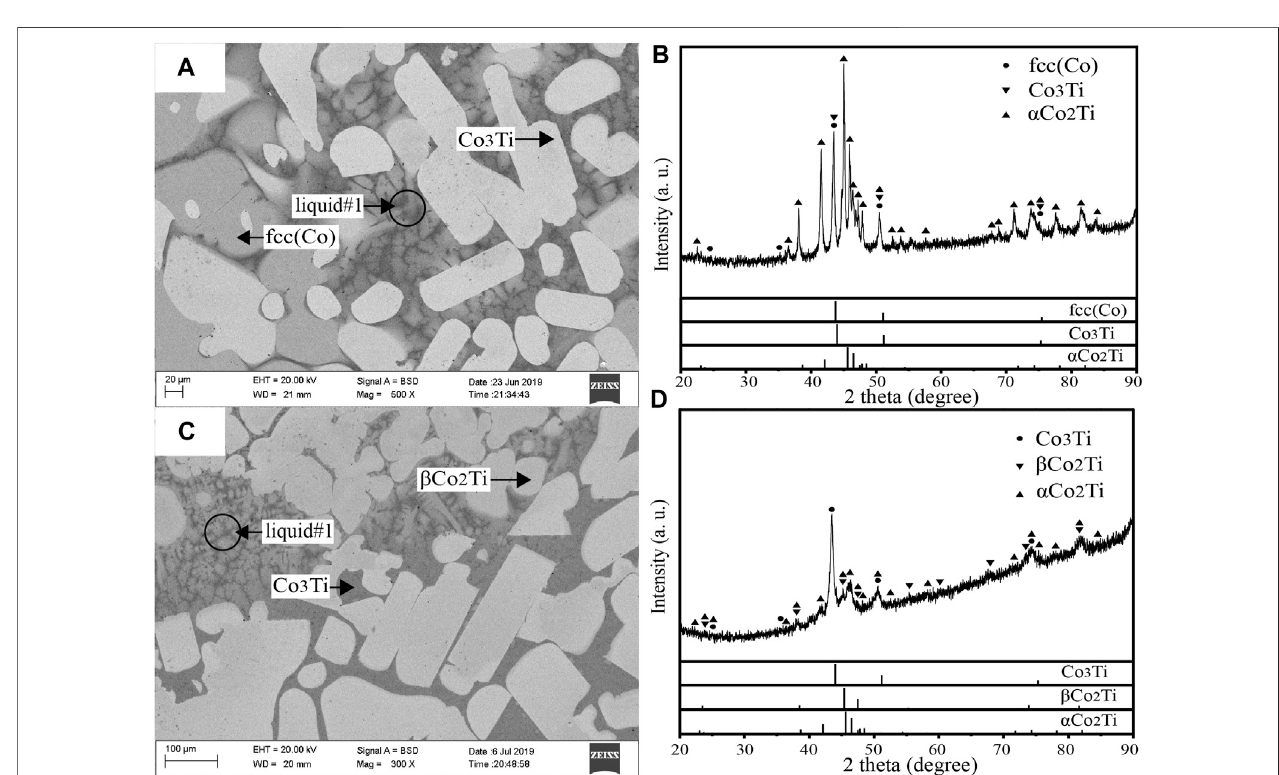
FIGURE 7 | BSE micrographs and XRD patterns of alloys (A) and (B) for b1 (C) and (D) for b2. Frontiers in Materials |